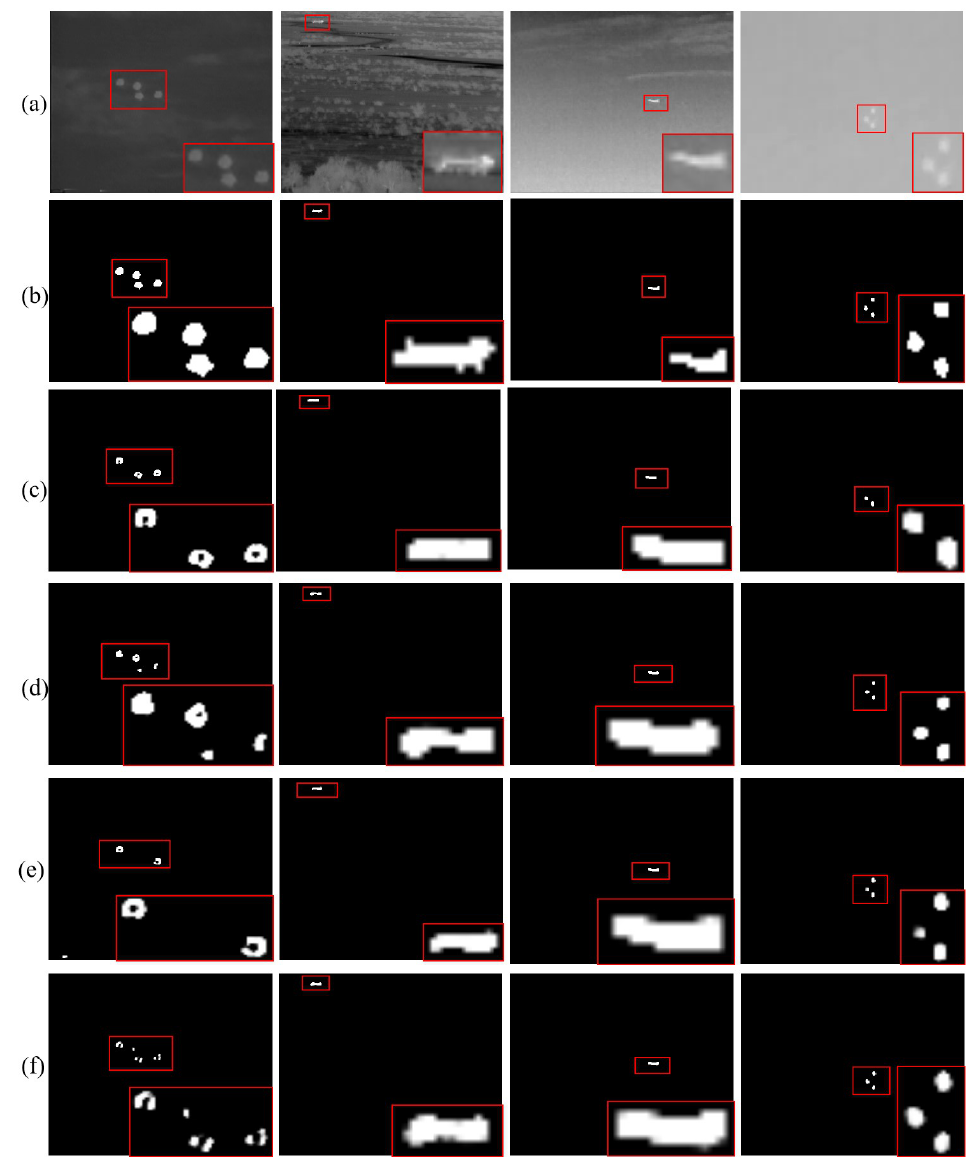
Figure 10. Segmentation results of proposed APANet on some infrared images. ( a ) The original image. ( b ) The ground truth. ( c – f ) The segmentation result of proposed APANet-P, APANet-H, APANet-rb-P, and APANet-rb-H,